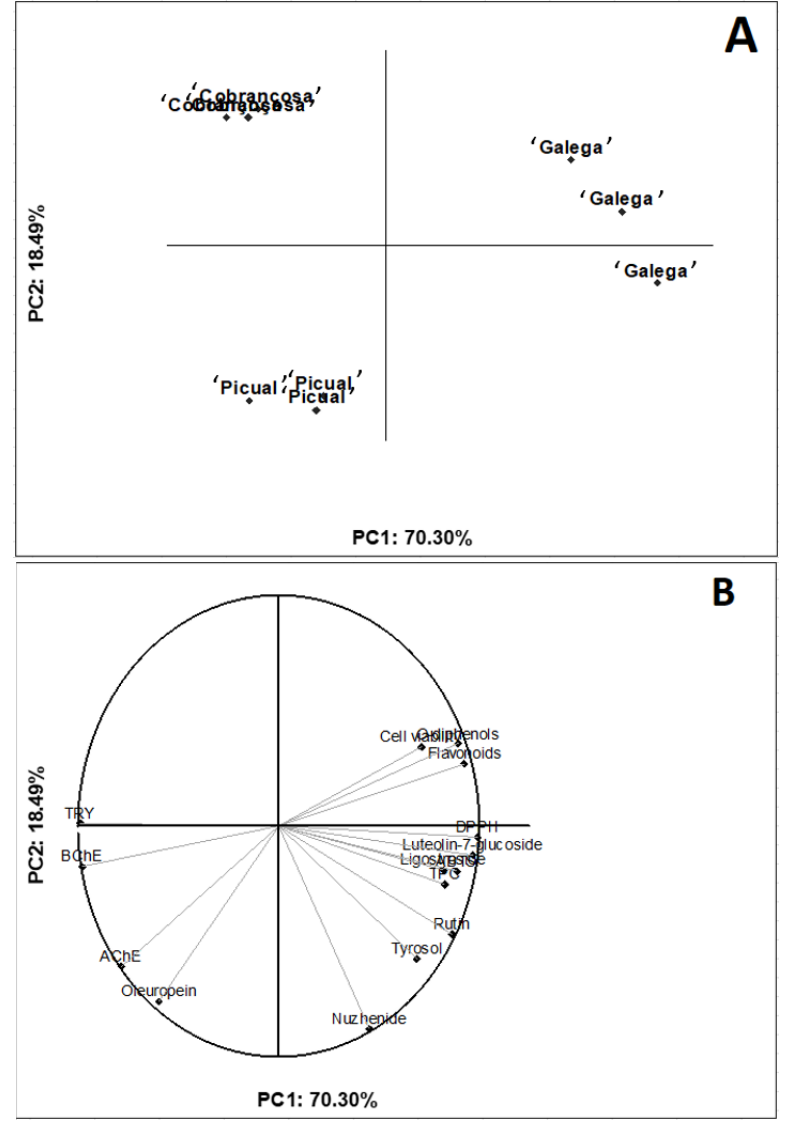
Figure 3. Two-dimensional projection of olive varieties to explain the effects of olive variety on the chemical composition and bioactivity. ( A ) Plot for the olive varieties and ( B ) plot for the responses. In the two-dimensional projection, it is possible to observe a clear differentiation be- tween the cultivars: the ‘Galega’ variety was characterized by high levels of bioactive